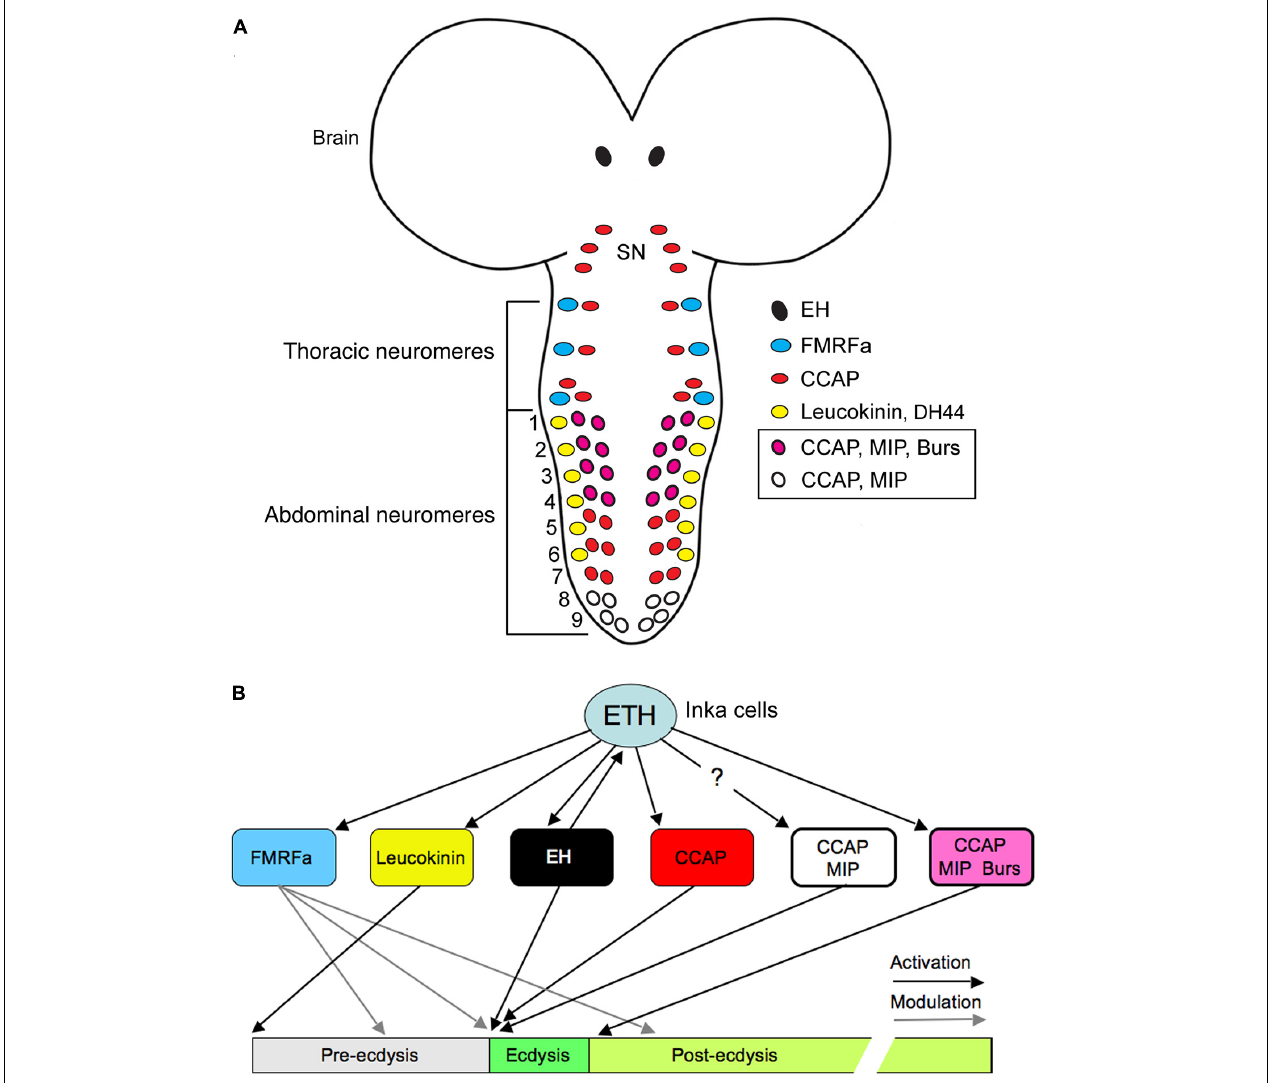
FIGURE 4 | Neurons and neuropeptides that control ecdysis motor activity in Drosophila . (A) Schematic depiction of peptidergic neurons in the larval CNS that express the ecdysis triggering hormone receptor ETHR-A. These neurons respond to ETH in a sequence and trigger ecdysis behavior as shown in (B) . The color-coding depicts the expression of various neuropeptides in the neurons (note that some colocalize 2–3 peptides). ETH is released from peritracheal Inka cells (not shown). SN, subesophageal neuromeres 1–3; ETH, ecdysis triggering hormone; FMRFa, FMRFamide; EH, eclosion hormone; CCAP, crustacean cardioactive peptide; MIP myoinhibitory peptide; burs, bursicon. Redrawn from Kim et al. (2006), Nässel and Winther